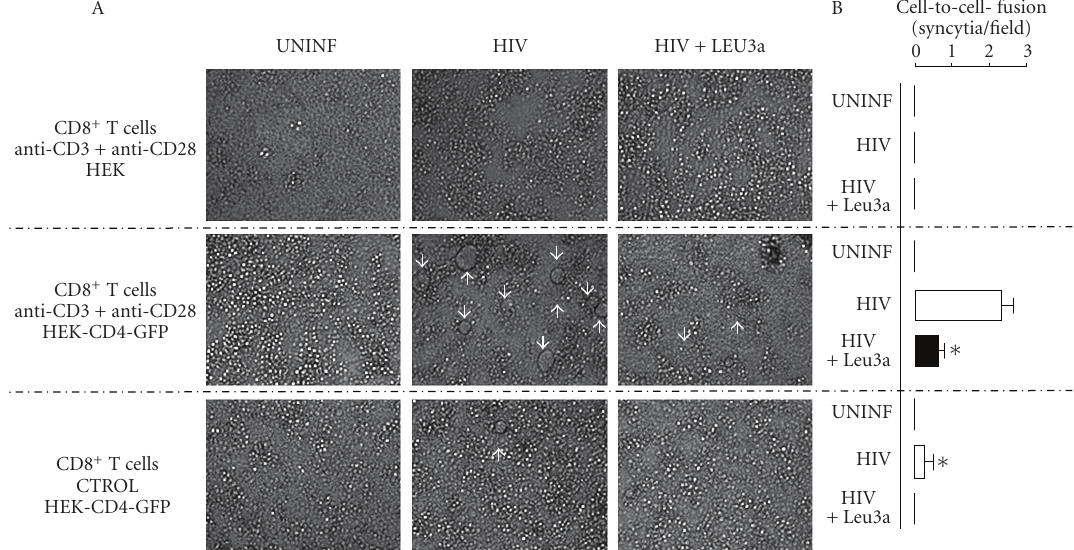
Figure 4: CD8 + T cells having acquired CD4 induced syncytia formation in infected MOLT-4 cultures. (A) Transmission microscopy analysis (low power fields) of cultures in which anti-CD3 + anti-CD28-activated CD8 + T cells that had been cocultured with HEK cells either expressing CD4-GFP (middle and lower panels) or not (upper panels), were then mixed with uninfected MOLT-4 cells (left panels) or HIV- infected MOLT-4 cells either in the absence (middle panels) or the presence (right panels) of the anti-CD4 mAb Leu3a. The controls shown on the bottom panels correspond to T cells that have been cocultured with HEK cells expressing CD4-GFP, but had not previously been activated with the anti-CD3 + anti-CD28 mAbs, (CTROL) white arrows indicate the positions of syncytia. (B) Quantification of syncytia in di ff erent randomly selected high power fields. Data are mean ± SD values of at least four di ff erent fields. Note that syncytia formation was never detected when uninfected MOLT-4 cells were used, whatever the condition tested. Asterisks denote statistically significant di ff erences between activated and control CD8 + T cells cocultured with HEK-CD4-GFP cells ( P = . 002, T test) and significant inhibition was induced by Leu3a ( P = . 001, T